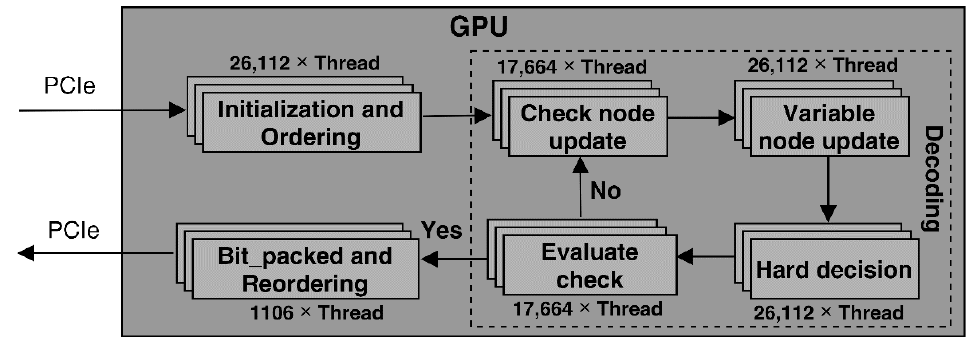
Figure 2. Process flow of the proposed GPU-based LDPC decoder with the evaluate check part.